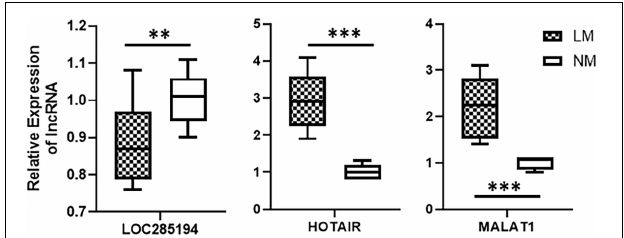
FIGURE 3 | Association of lncRNAs with liver metastases. Expression levels of lncRNAs were tested in primary colorectal cancers, by qRT-PCR, collected at the time of initial diagnosis. Expression levels in n = 12 patients who reported liver metastases (LM) within 5 years of diagnosis were compared with expression levels in n = 5 patients with no reported metastases (NM: no metastasis). ** p < 0.01, *** p < 0.001.